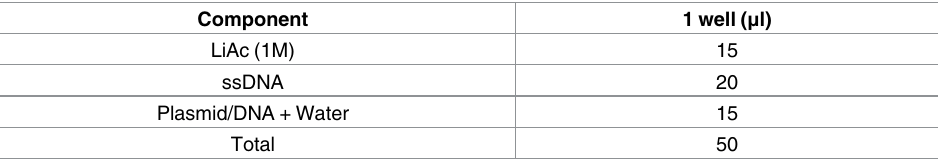
Table 1. Transformation